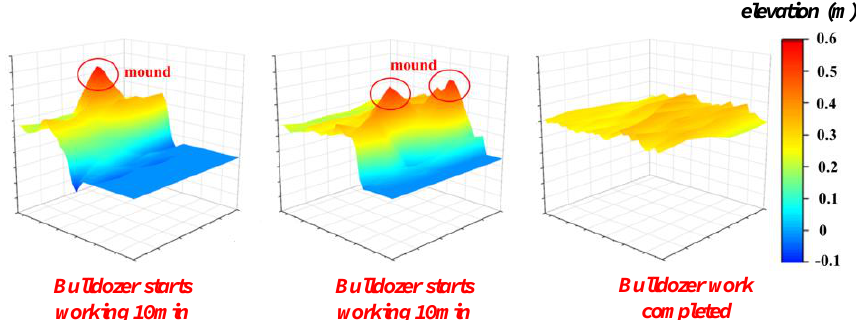
Figure 10. Three-dimensional colour map of the elevation of the entire working area.